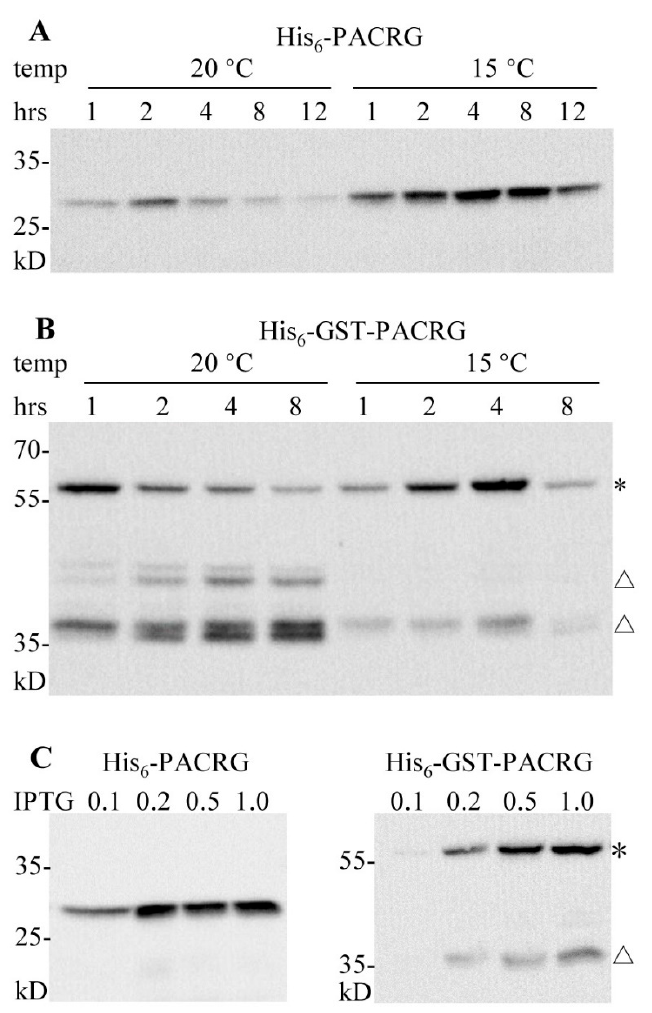
Figure 2. Optimization of expression conditions for pCold-PACRG and pCold-GST-PACRG. ( A , B ) WB analysis of pCold-PACRG and pCold-GST-PACRG expressions with 0.5 mM IPTG for various induction durations at 20 °C and 15 °C, respectively. ( C ) WB analysis of pCold-PACRG and pCold-GST-PACRG expressions induced with various concentrations of IPTG for 4 h at 15 °C. * denotes His 6 -GST-PACRG; △ denotes degraded His 6 -GST-PACRG.